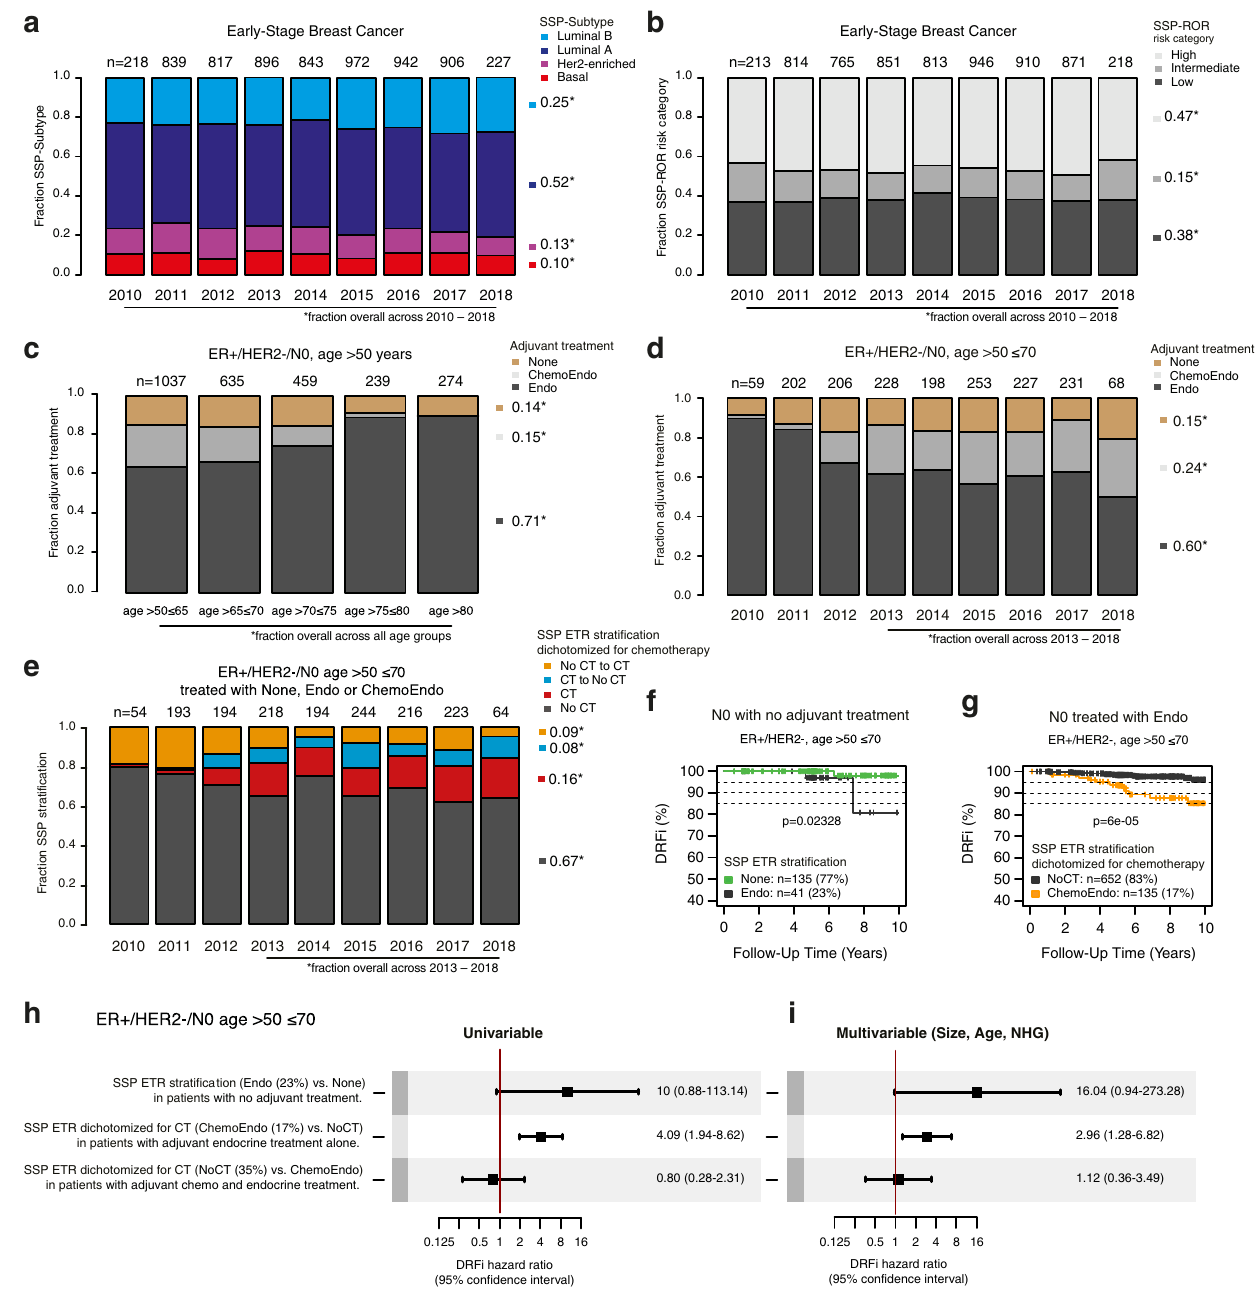
Fig. 5 SSP classi fi cations for Subtype and ROR risk category in early-stage breast cancer and cross-comparison with administered systemic treatment. The basis for comparisons is the 6660-patient follow-up cohort (Table 1). Summarized proportions are shown on the right side of bar graphs. The fi rst and last year of enrollment (2010 and 2018) are not full calendar years and therefore include notably smaller numbers of enrolled patients. a Proportions of SSP-Subtype by year of diagnosis. b Proportions of SSP-ROR risk category by year of diagnosis. c Proportions for adjuvant treatment within ER + /HER2-/N0 patients diagnosed at age >50 years by different age at diagnosis. Endo: endocrine therapy only, ChemoEndo: adjuvant chemotherapy and endocrine therapy. None: no adjuvant systemic therapy. d Proportions for adjuvant treatment within ER + /HER2-/N0 patients diagnosed at age >50 ≤ 70 years by year of diagnosis. e Cross-comparison of the naive SSP ETR dichotomized for chemotherapy (yes/no) with records of administered systemic treatment within ER + /HER2-/N0 patients at age >50 ≤ 70. The groups for which SSP treatment recommendation is in agreement with the administered treatment are shown in black for regimen without chemotherapy (No CT) and in red for regimen including chemotherapy (CT). The discordant groups where SSP would lead to escalation of treatment (No CT to CT) are shown in orange and de-escalation of treatment (CT to No CT) in blue. f Kaplan-Meier plot for SSP strati fi cation by SSP-ETR treatment recommendation within the N0 subgroup of ER + /HER2- patients diagnosed at age >50 ≤ 70 and no adjuvant treatment. g Kaplan-Meier plot for SSP strati fi cation by SSP-ETR dichotomized for chemotherapy (chemotherapy vs. no chemotherapy) within ER + /HER2-/N0 patients diagnosed at age >50 ≤ 70 treated with adjuvant endocrine therapy only. h Forest plots of Hazard ratios and 95% con fi dence interval ranges from univariable and i multivariable Cox regression using DRFi as endpoint strati fi ed using SSP treatment recommendation. Multivariable analysis is with tumor size, age at diagnosis, and NHG as covariates. Test (SSP strati fi cation) and subgroup (administered treatment) is speci fi ed on the left of the univariable forest plot. Error bars correspond to 95% con fi dence